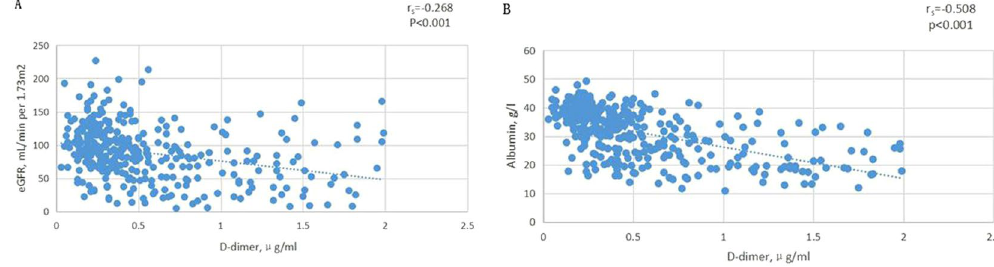
Figure 3. Scatter diagram for the correlation of D-dimer with eGFR and albumin in D-dimer < 2.00 μ g/ml. ( A ) Negative correlation of D-dimer level with eGFR. ( B ) Negative correlation of D-dimer level with albumin.